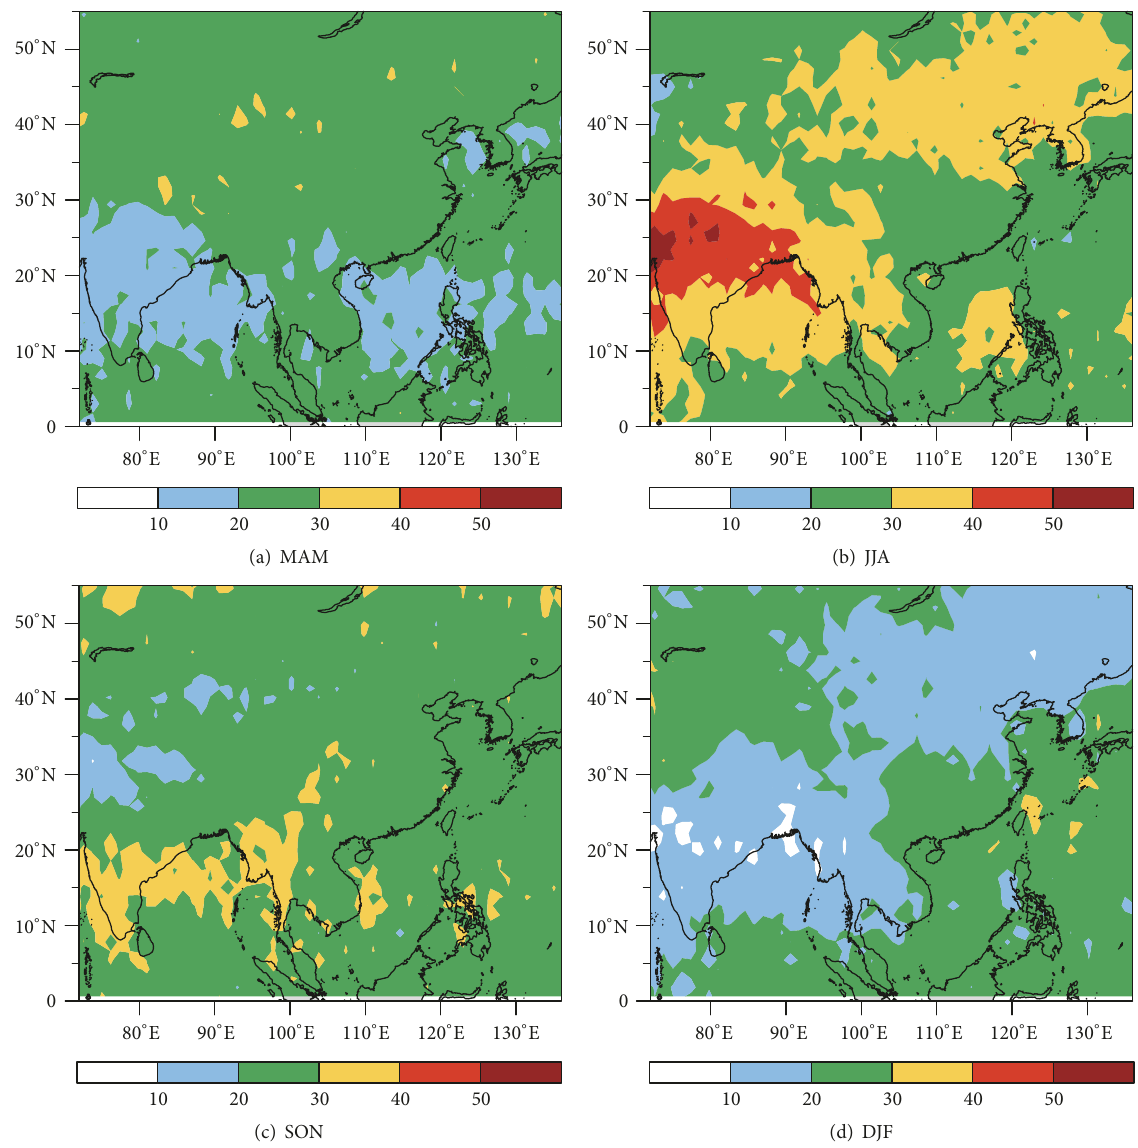
Figure 7: Seasonal variations in the distribution of single-layer cloud occurrence in different seasons (MAM, JJA, SON, and DJF), %.